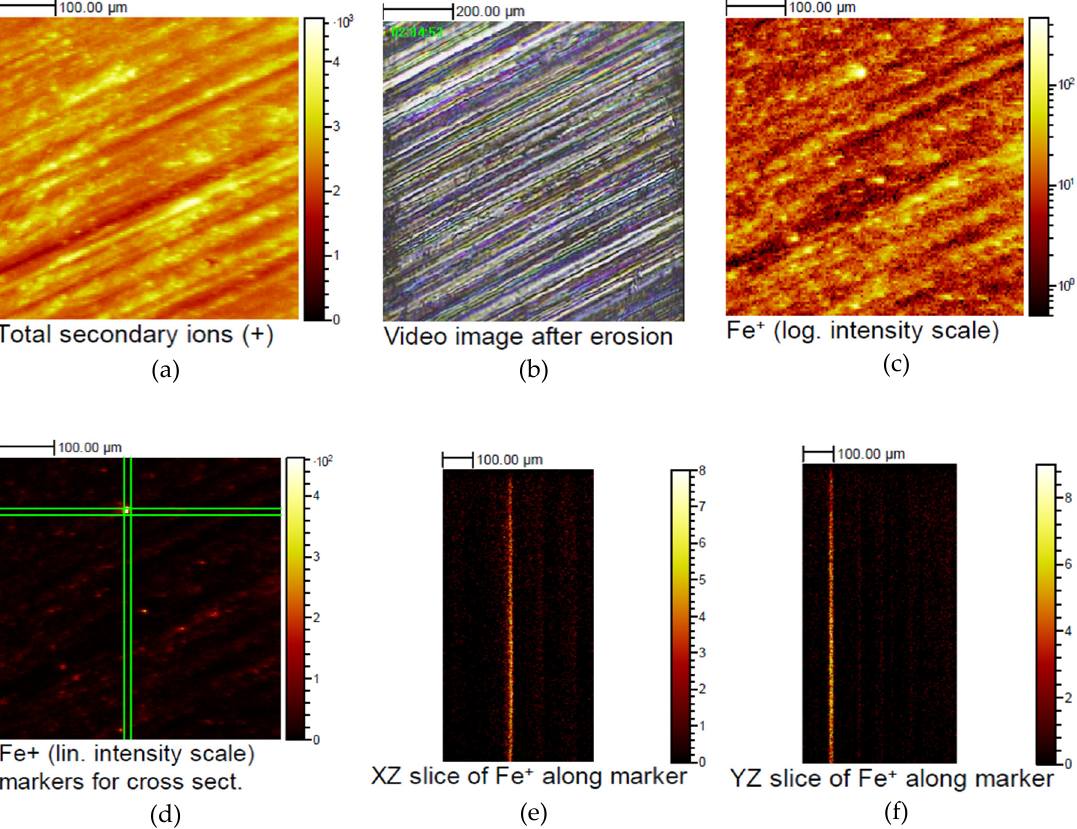
Figure 11. Lateral distribution of the Fe containing inclusions in Mg-10Gd corresponding to the depth profile: ( a ) total secondary ion image; ( b ) micrograph showing the measurement position; ( c ) depth-integrated lateral distribution of Fe with a log intensity scale; ( d ) integrated Fe signal with linear intensity scale, highlighting an individual Fe particle; ( e ) calculated cross sections in the XZ plane along the green indicators centered on the Fe particle; ( f ) calculated cross sections in the YZ plane along the green indicators centered on the Fe particle.